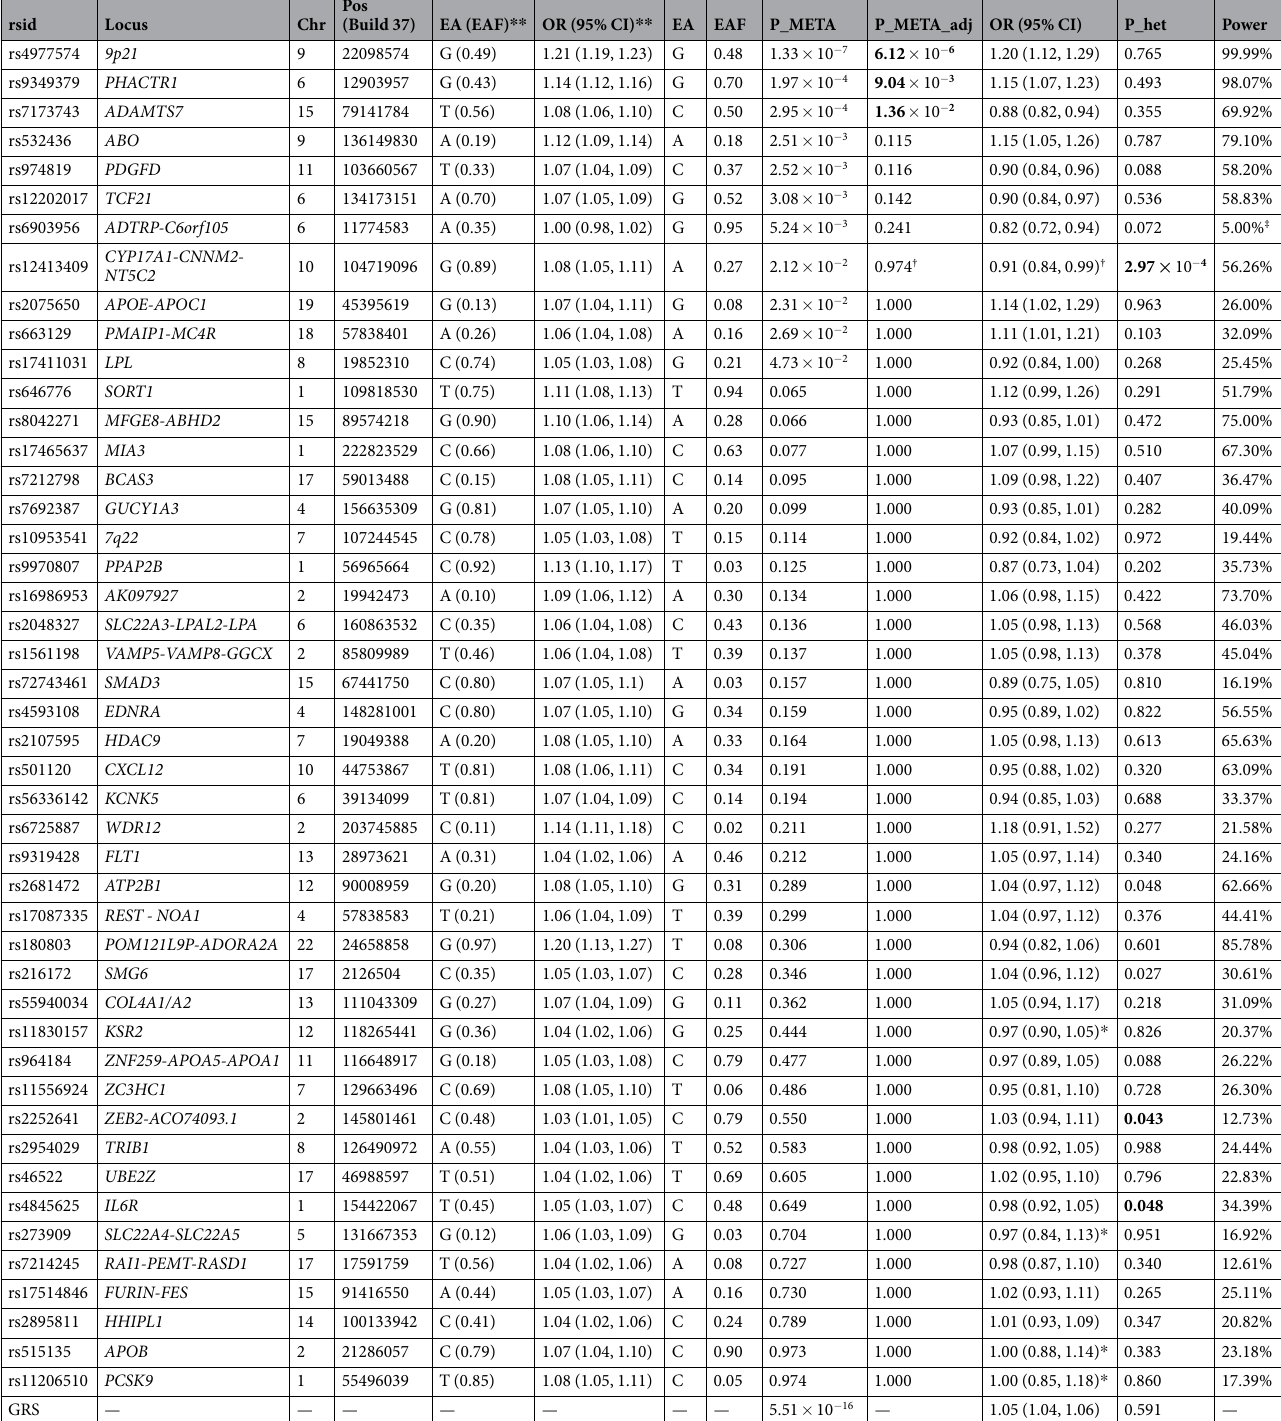
Table 3. Association results of previously reported index SNPs among predominantly Europeans after meta- analysis of the 5 Singaporean Asian datasets (2,460 cases; 9,223 controls). EA: Effect allele; EAF: Effect allele frequency; OR: odds ratio; CI: confidence interval; MA: minor allele; P_META_adj: P_META adjusted for 46 tests; P_het: P values for Cochran’s Q; GRS: genetic risk score. * Inconsistent direction with previous GWAS. ** EF and OR from the reference: CARDIoGRAMplusC4D Consortium. A comprehensive 1000 Genomes- based genome-wide association meta-analysis of coronary artery disease. Nat Genet. 2015: 47: 1121–1130. † Shown here in fixed effect, and recalculated in random effect with P-meta = 0.255, OR = 0.898. ‡ Shown here the power calculation based on the ref. 3 , and recalculated based on the ref. 9 , Power =